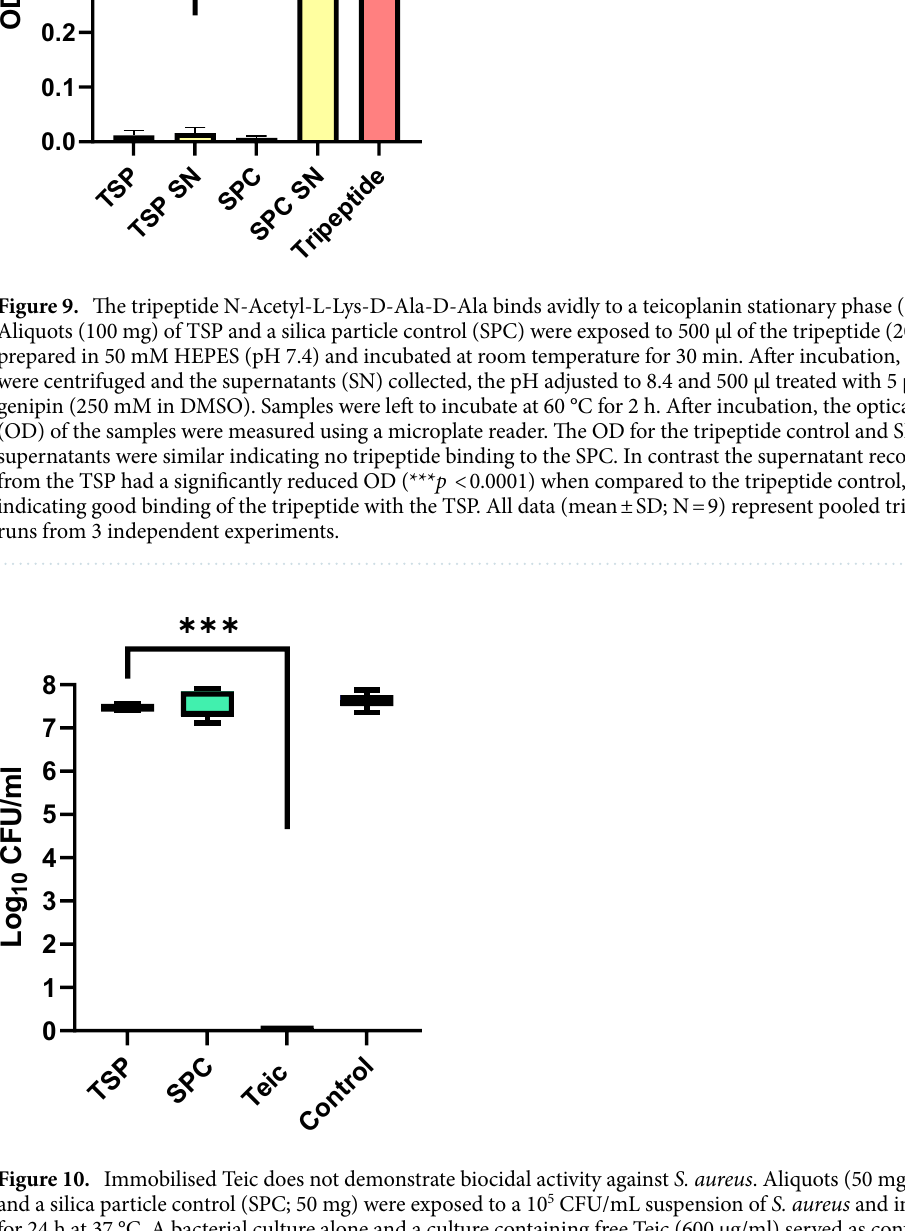
that Teic remained bound to TiO 2 even when left incubated under neutral conditions for a week at 37 °C (data not shown). However, when Teic-functionalised Ti discs were subjected to a mock bacterial culture the conditioned media exhibited antibacterial activity. It was clear that the antibiotic was leaching from the metal surface, and this was the reason why the functionalised Ti was able to kill S. aureus . We subsequently found that phosphate